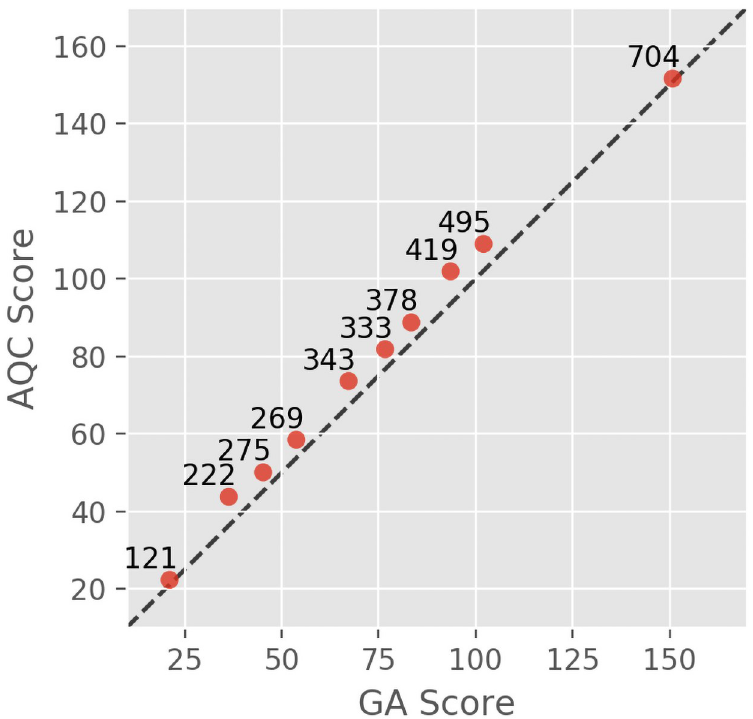
Fig 3. QA vs GA for 10 full-length proteins. Dashed line represents y = x. Lower scores indicate higher probability of expression. Point labels indicate number of amino acids.